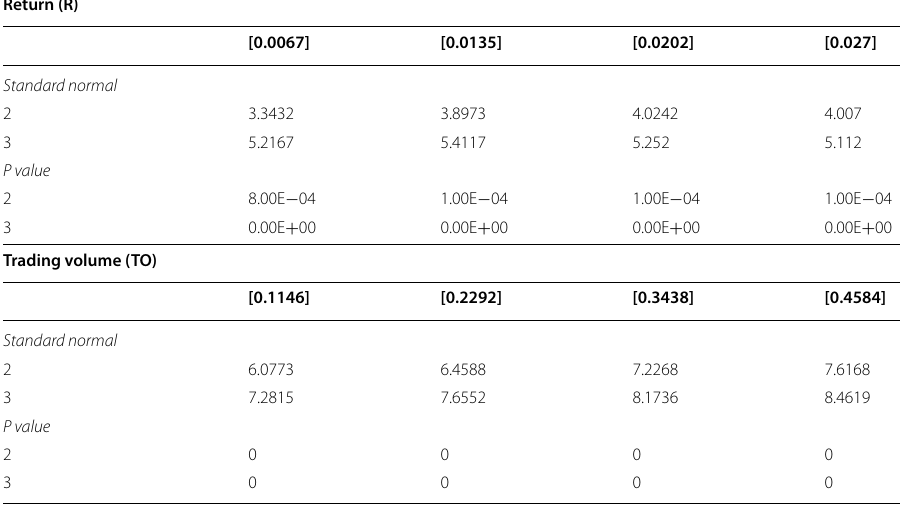
Table 4 BDS test results of return and trading